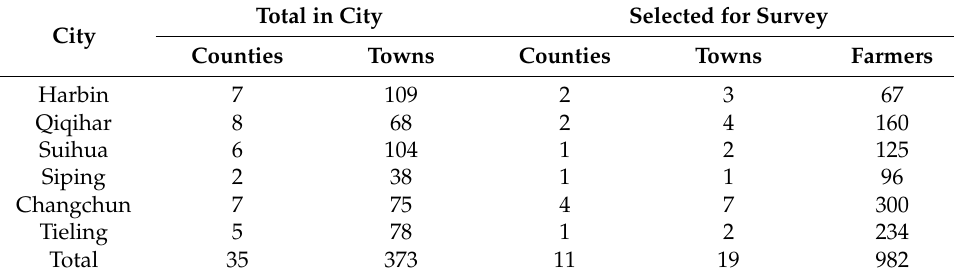
Figure 2. Map of the study area and spatial distribution of the sample villages. Table 1. Basic characteristics of the sample.